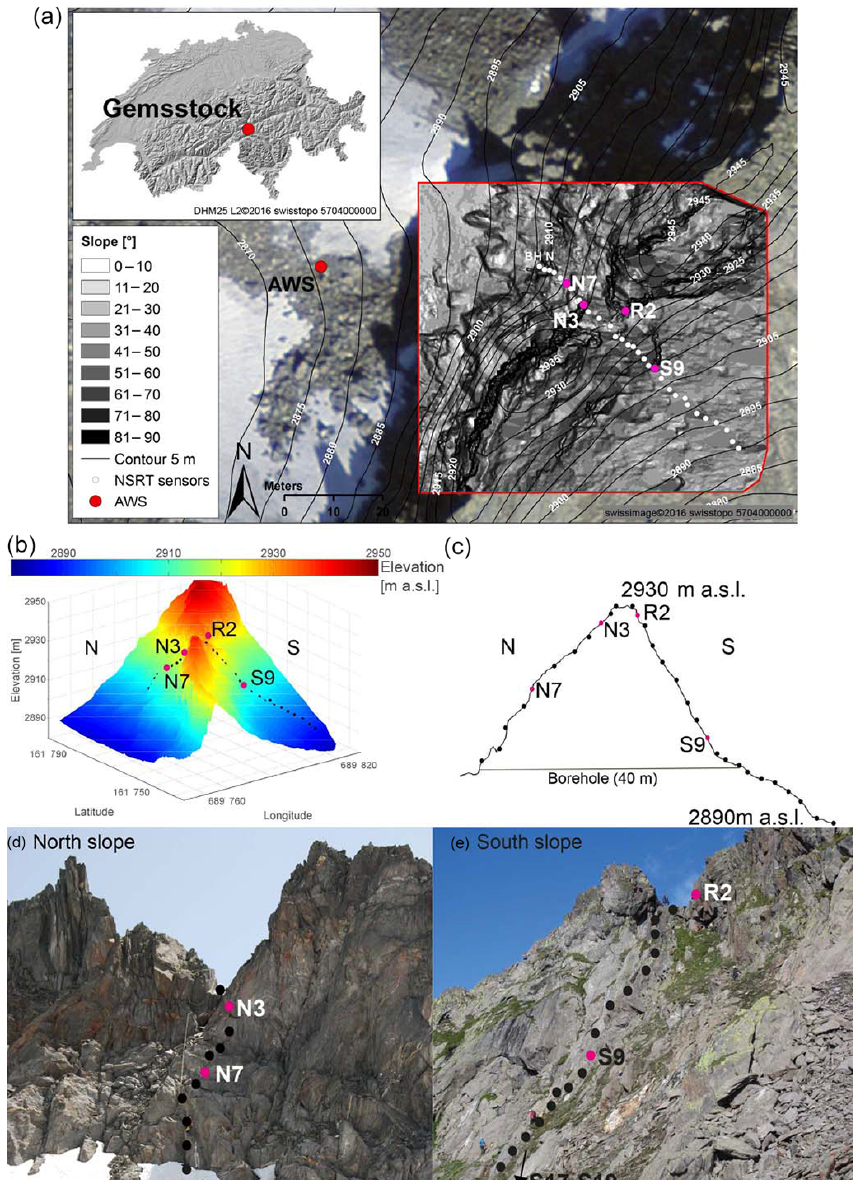
Figure 1. The Gemsstock study site. (a) The Alpine3D model domain with slope angles (red rectangle) based on TLS data, as well as the locations of the AWS and the NSRT devices. The location of Gemsstock in the Swiss Alps is shown in the top left inset. (b) Three- dimensional view of the DEM of Gemsstock and (c) the cross section of the Gemsstock ridge with all 30 NSRT locations. Photographs showing the (d) N and (e) S rock faces and the measurement set-up. (b–e) Black dots indicate the locations of the 30 NSRT locations and selected ones, discussed in further detail in the text, are highlighted in pink and